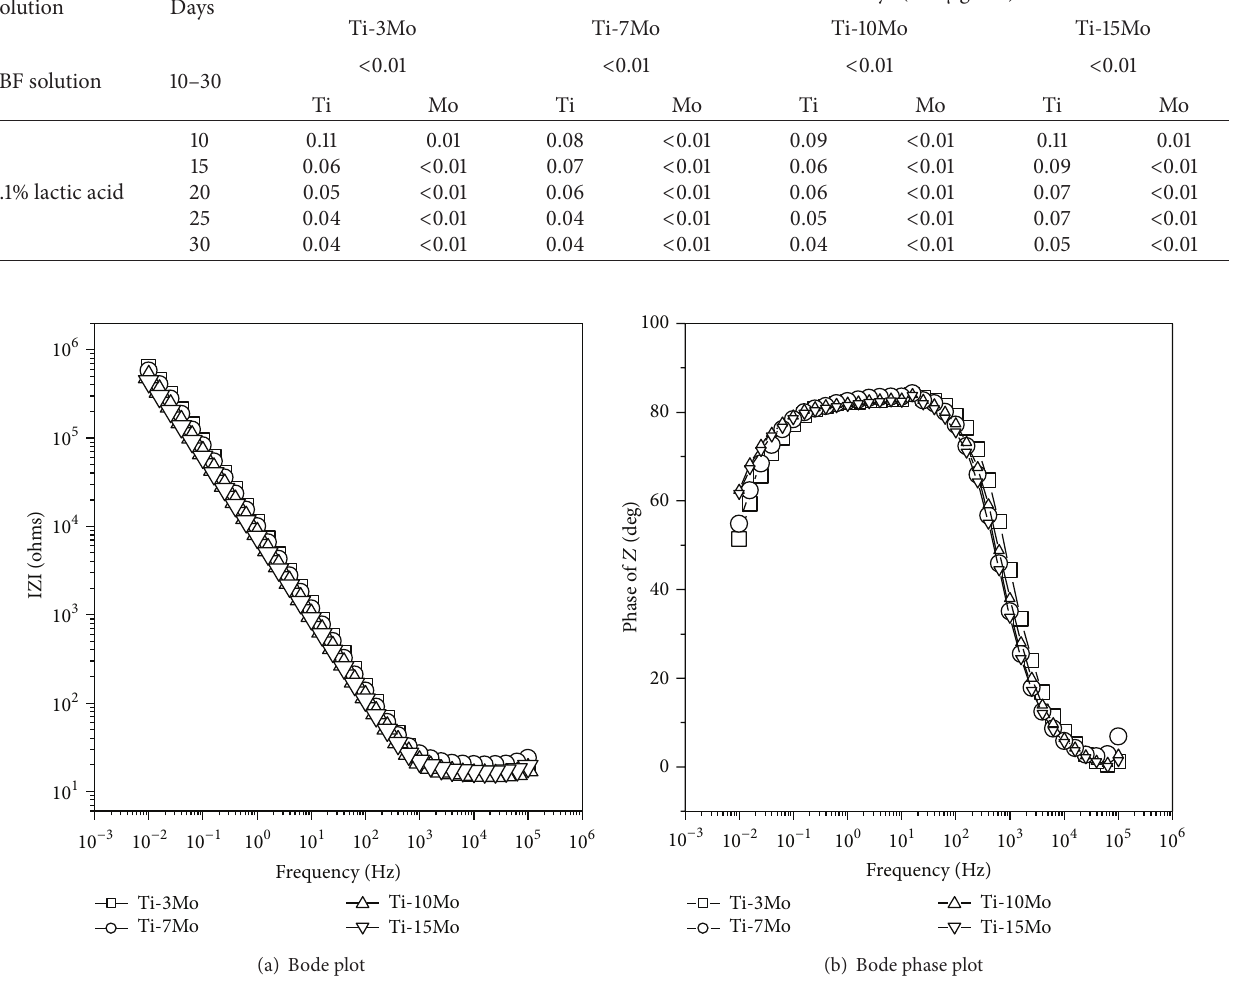
Figure 5: Bode spectra for the Ti-Mo alloys: (a) Bode magnitude plots and (b) Bode phase plots.